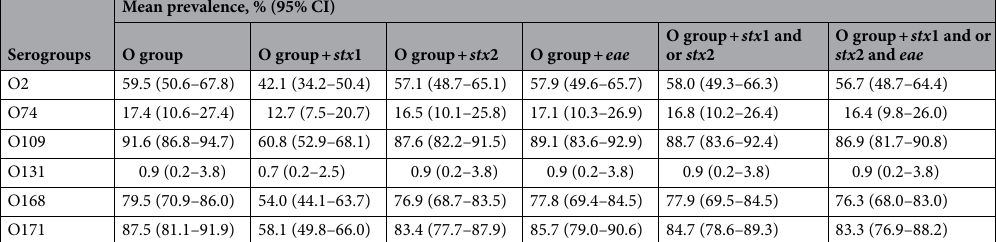
Table 5. Model-adjusted mean prevalence and 95% confidence intervals (CI) of Escherichia coli O serogroups and virulence genes that encode for Shiga toxin 1 ( stx 1) and 2 ( stx 2) and intimin ( eae ) determined by multiplex PCR in fecal samples (n = 576) from feedlot